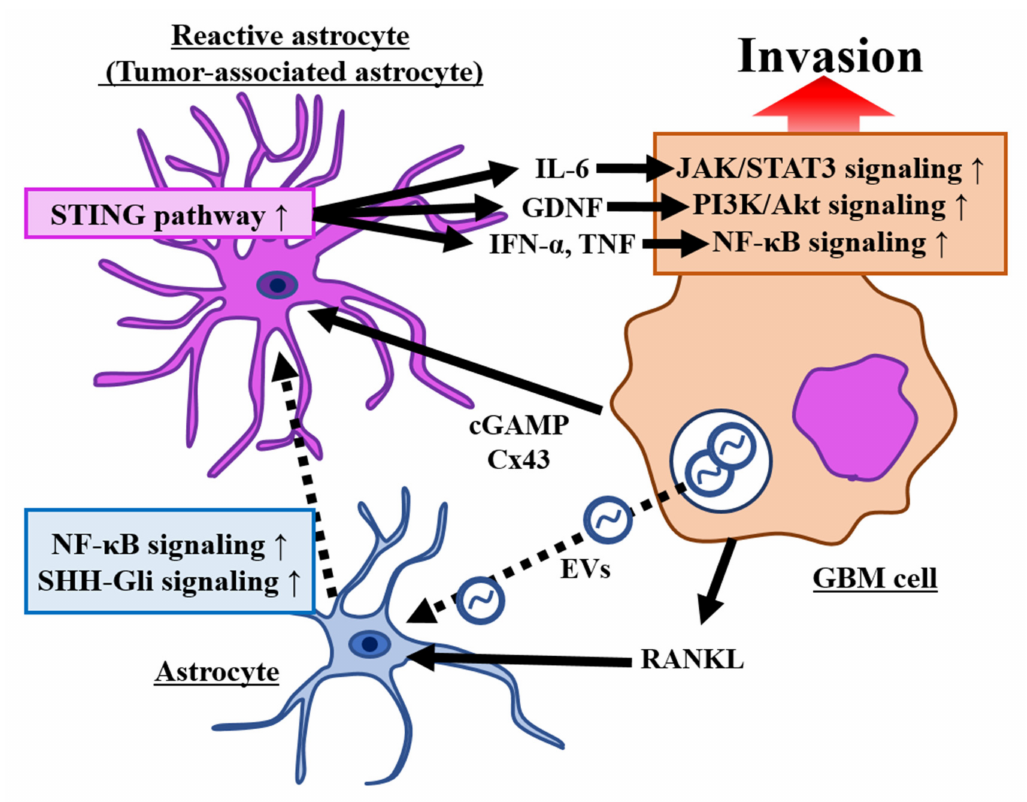
Figure 3. Signaling pathways of glioma–astrocyte crosstalk associated with invasion. The major signaling pathways involved in glioma–astrocyte crosstalk that promote tumor invasion (Black arrows). The activation of nuclear factor kappa-B (NF- κ B) and sonic hedgehog (SHH)-Gli signaling pathway induced normal astrocytes into reactive astrocytes (tumor-associated astrocytes (TAAs)). TAAs promote glioma cell invasion by activating some pathways, such as Janus kinase (JAK)/signal transducer and activator of transcription (STAT), phosphatidylinositol-3 kinase (PI3K)/Akt, and NF- κ B pathways. The squared arrows show indirect pathways. Abbreviation: cGAMP; 2 (cid:48) 3 (cid:48) -cyclic GMP-AMP, Cx43; connexin 43, EVs; extracellular vesicles, GBM; glioblastoma, GDNF; glial cell line-derived neurotrophic factor, IFN- α ; interferon- α , IL; interleukin, RANKL; receptor activator of nuclear factor kappa-B ligand, STING; stimulator of interferon genes, TNF; tumor necrosis